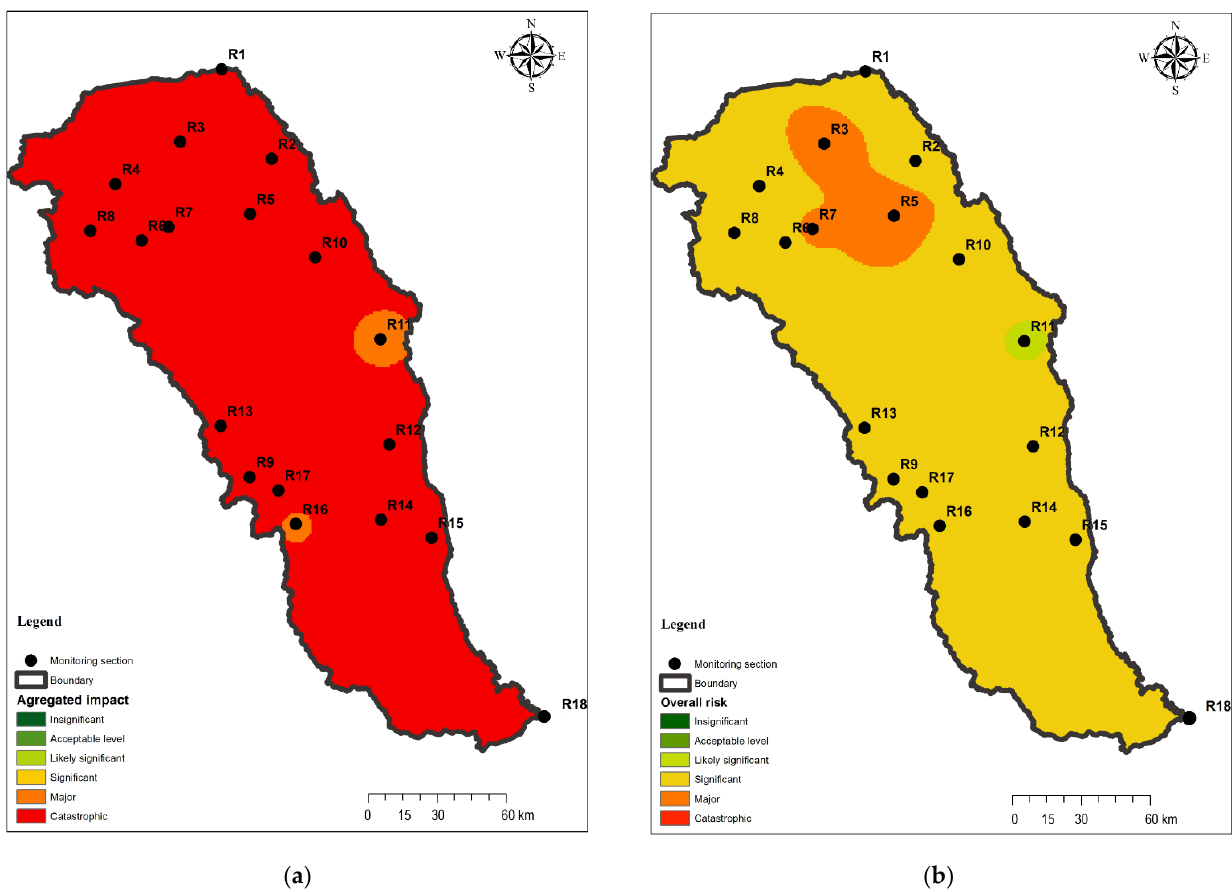
Figure 7. ( a ) Global environmental impact distribution; ( b ) global risk exposure distribution .